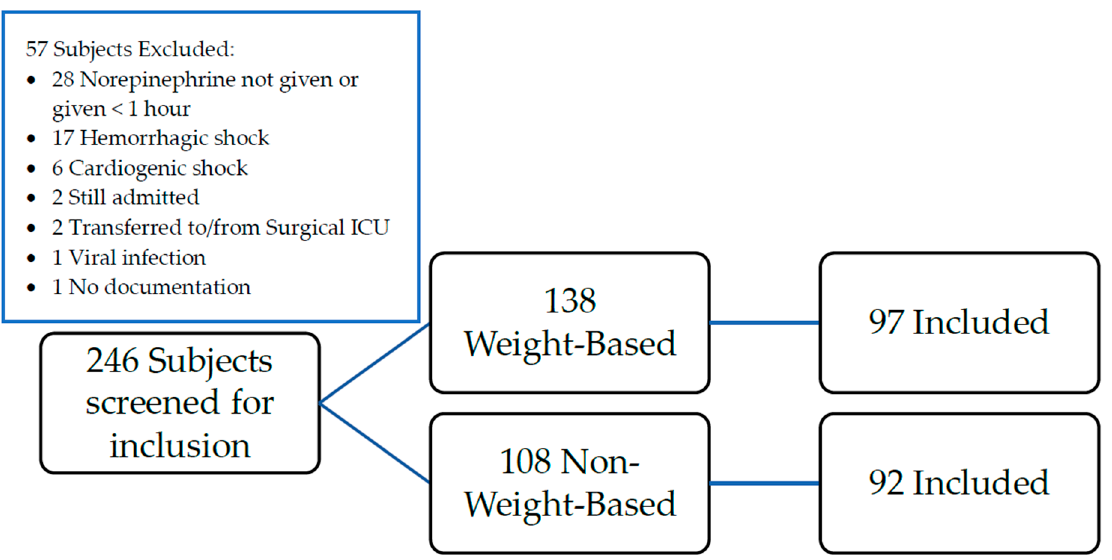
Figure 1. Patient Enrollment. A total of 97 patients received weight-based norepinephrine while 92 patients received non-weight-based norepinephrine; 57 patients were excluded. The most common reasons for exclusion were receipt of norepinephrine for less than one hour (n = 28) or having hemorrhagic shock (n = 17).